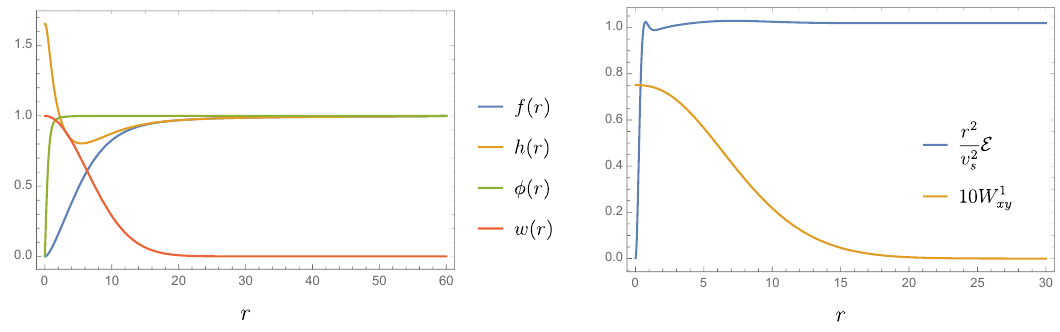
Figure 4 . Numerical solution for the type-C string. We take the same benchmark parameters as figure 2. Also we adopt a length unit as v − 1 = 0 . 5 . (left): plots of profile functions. The behavior s of the scalar profile functions are the same as one in figure 3. The profile function of the W 1 field, w ( r ) , approaches to zero as r → ∞ starting from unity at r = 0 . (right): plots of energy density (3.45) divided by v 2 /r 2 and the W 1 -flux density multiplied by 10 . The tension integrated s over 0 ≤ r ≤ 120 v − 1 is 140 . 604 . The total value of the W 1 -flux is calculated to 19 . 3208 , which is s consistent with eq.